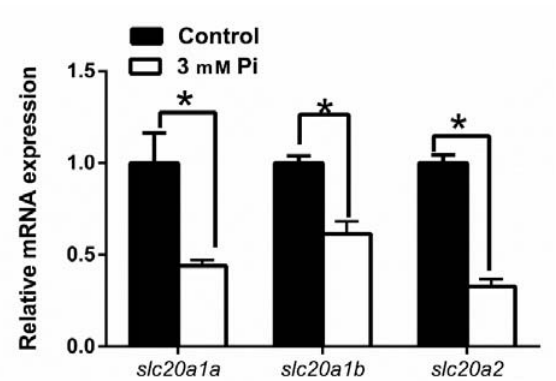
Figure 6. E ff ect of Pi incubation on the mRNA level of slc20s in CIK cells. Student’s t-test was undertaken to detect the di ff erences between two treatments. Asterisk (*) indicates significant di ff erences between Figure 6. Effect of Pi incubation on the mRNA level of slc20s in CIK cells. Student’s t ‐ test was control and Pi treatment group ( p < undertaken to detect the differences between two treatments. Asterisk (*) indicates significant differences between control and Pi treatment group ( p < 0.05).